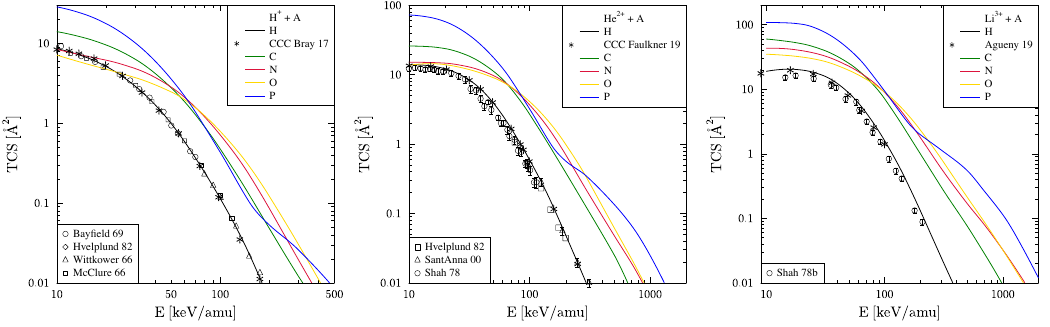
Figure 1. In the left panel the net capture cross sections for protons colliding with atoms H, C, N, O, P is shown (solid lines) as calculated with the two-center basis generator method (TC-BGM) using basis sets described in the text, the middle panel is for He 2 + projectiles, while the right panel is for the case of Li 3 + projectiles. For atomic hydrogen targets and proton and He 2 + projectiles the results are compared with the convergent close coupling calculation of References [12,13], respectively. For Li 3 + impact we compare with data from Reference [14]. For proton impact the experimental data are from References [15–18], for He 2 + impact from References [18–20], and for Li 3 + − H collisions from Reference